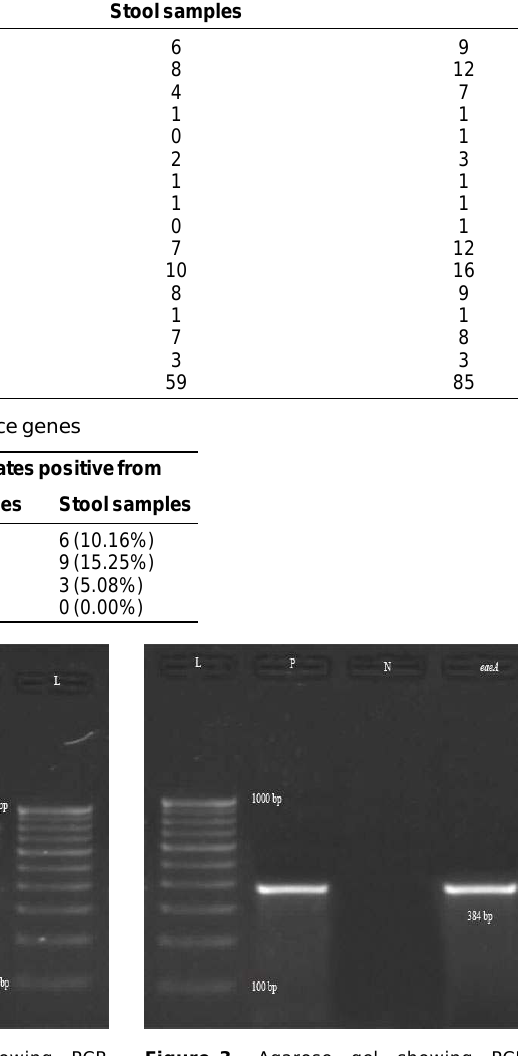
Table-2. Serotype of E. coli isolates Sr. No. ‘O’ Serogroup No. of E. coli isolated from